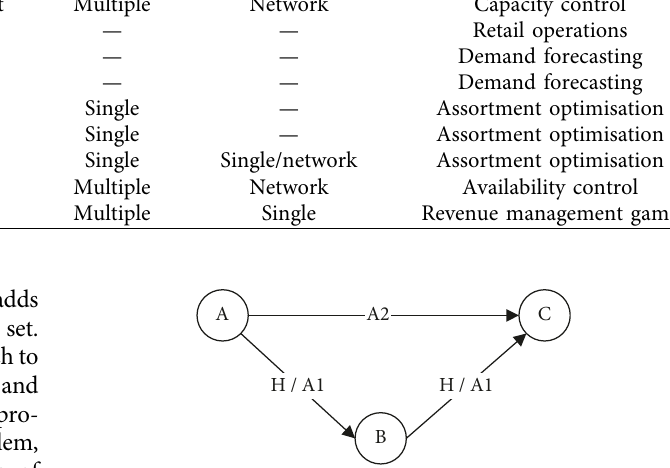
Figure 1: Transportation